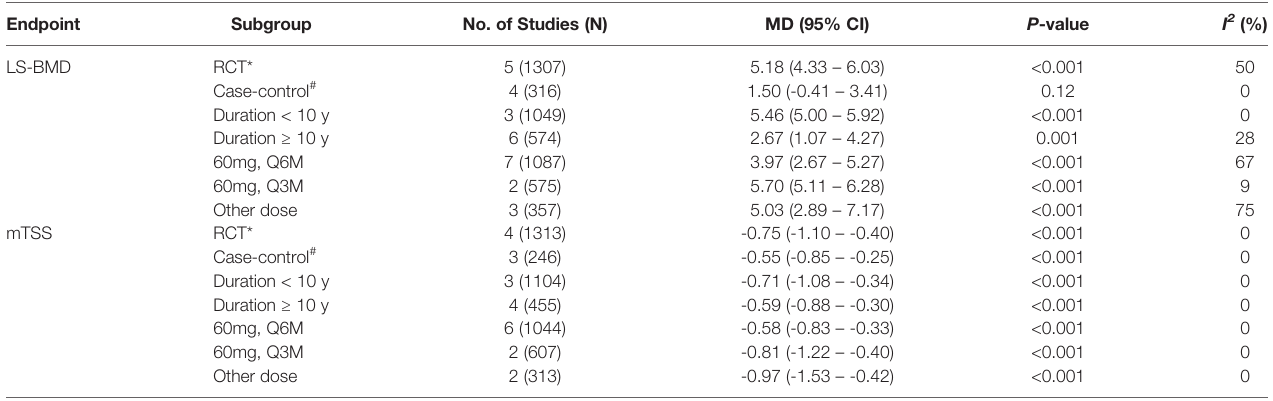
TABLE 2 | Outcomes of subgroup